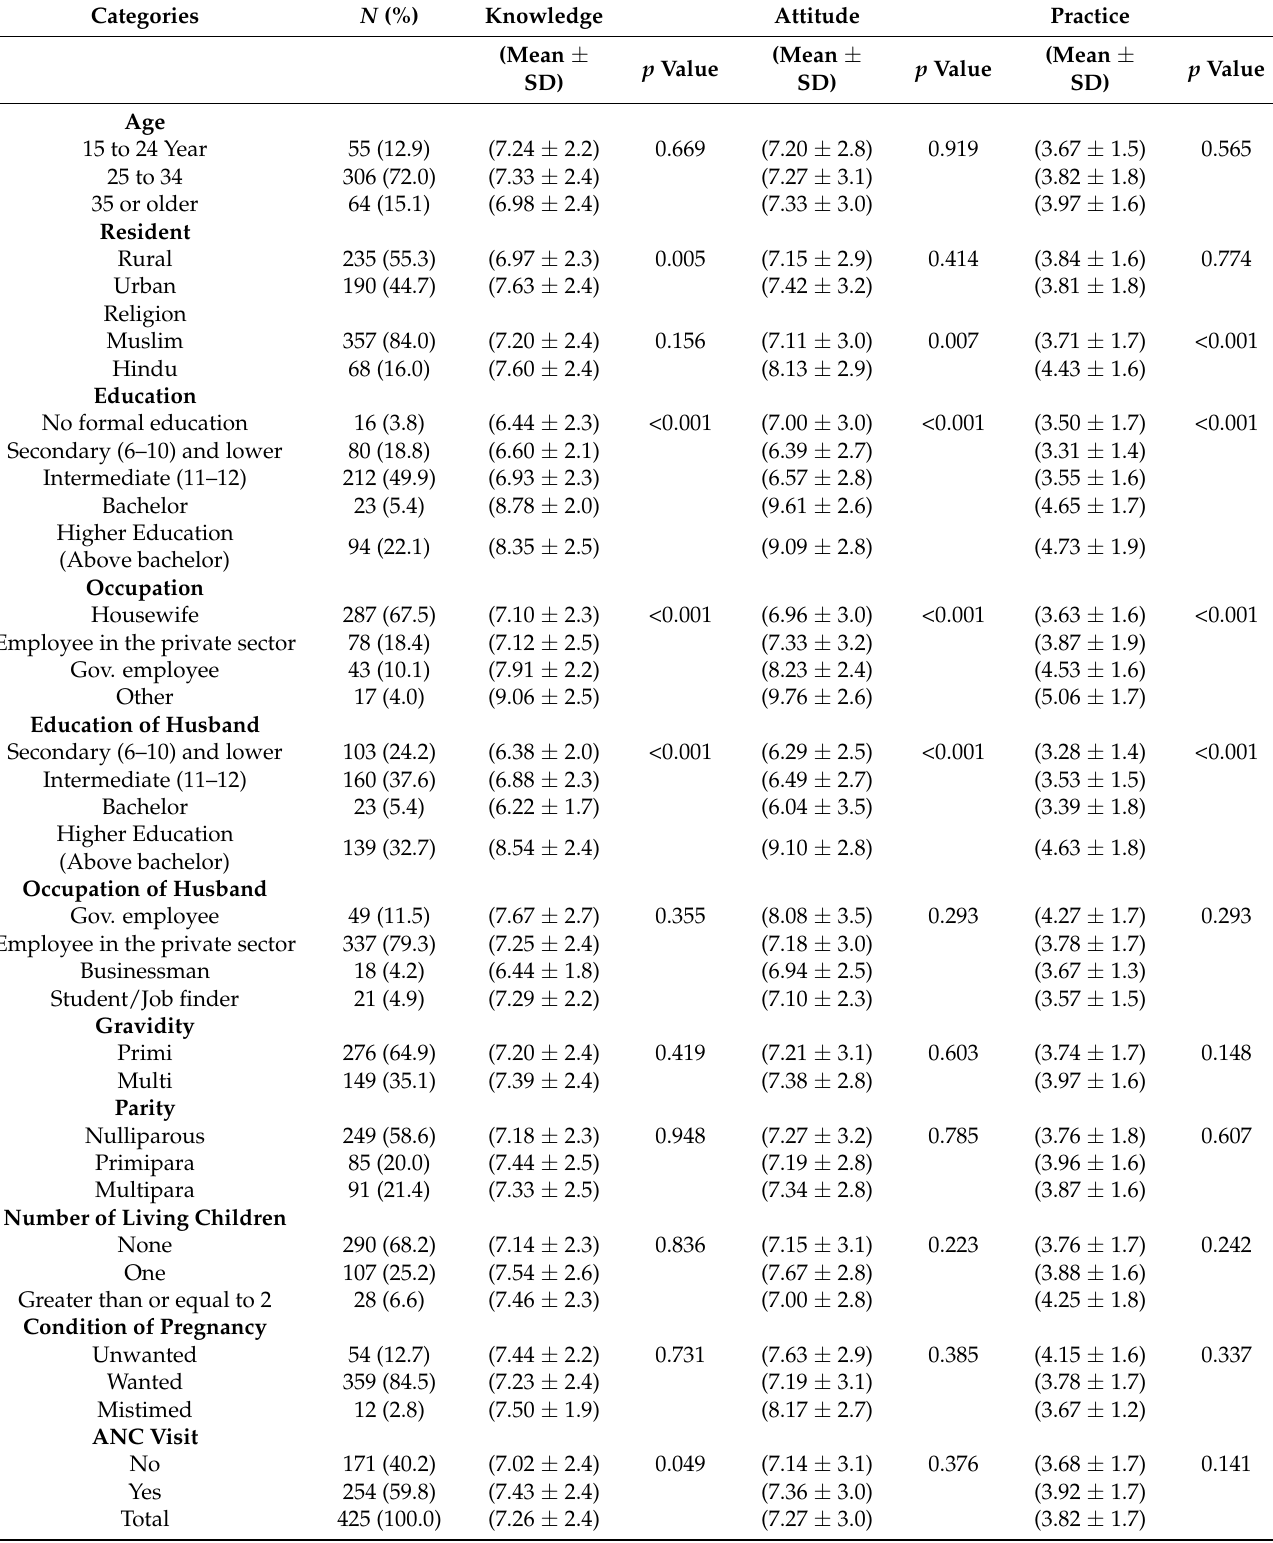
Table 3. Differences in participant’s mean score of COVID-19 related to KAP ( n =